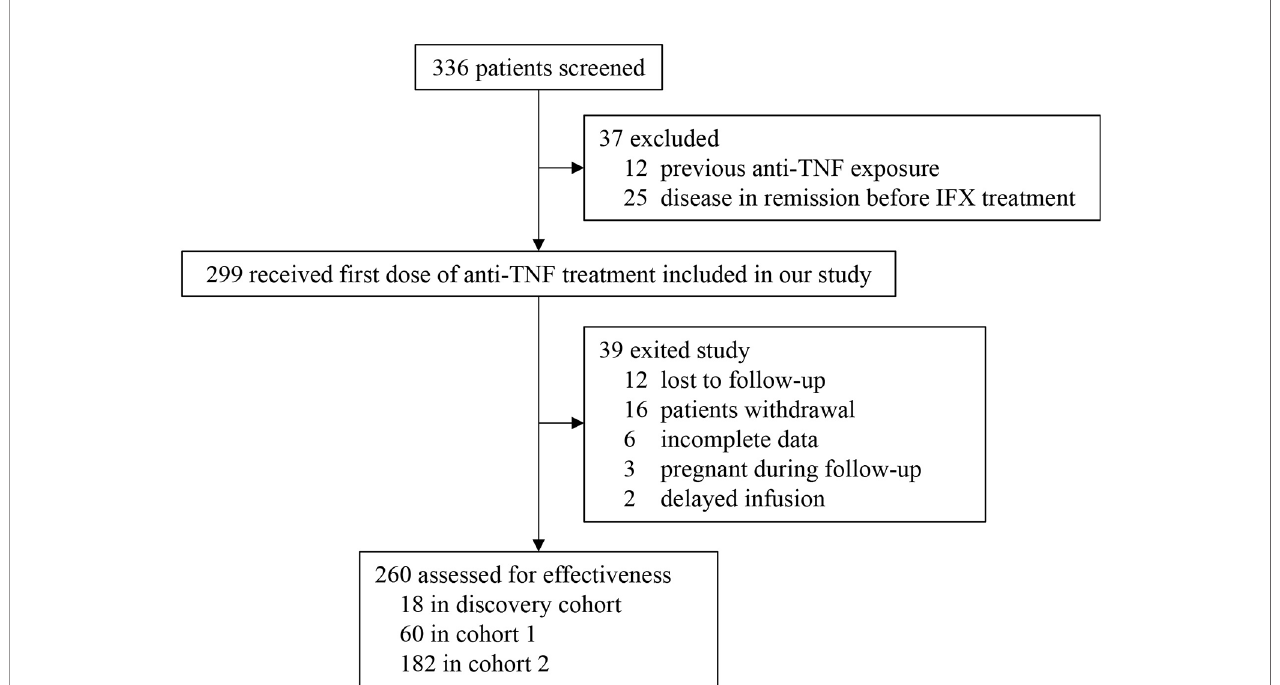
FIGURE 1 | The fl ow chart of patient